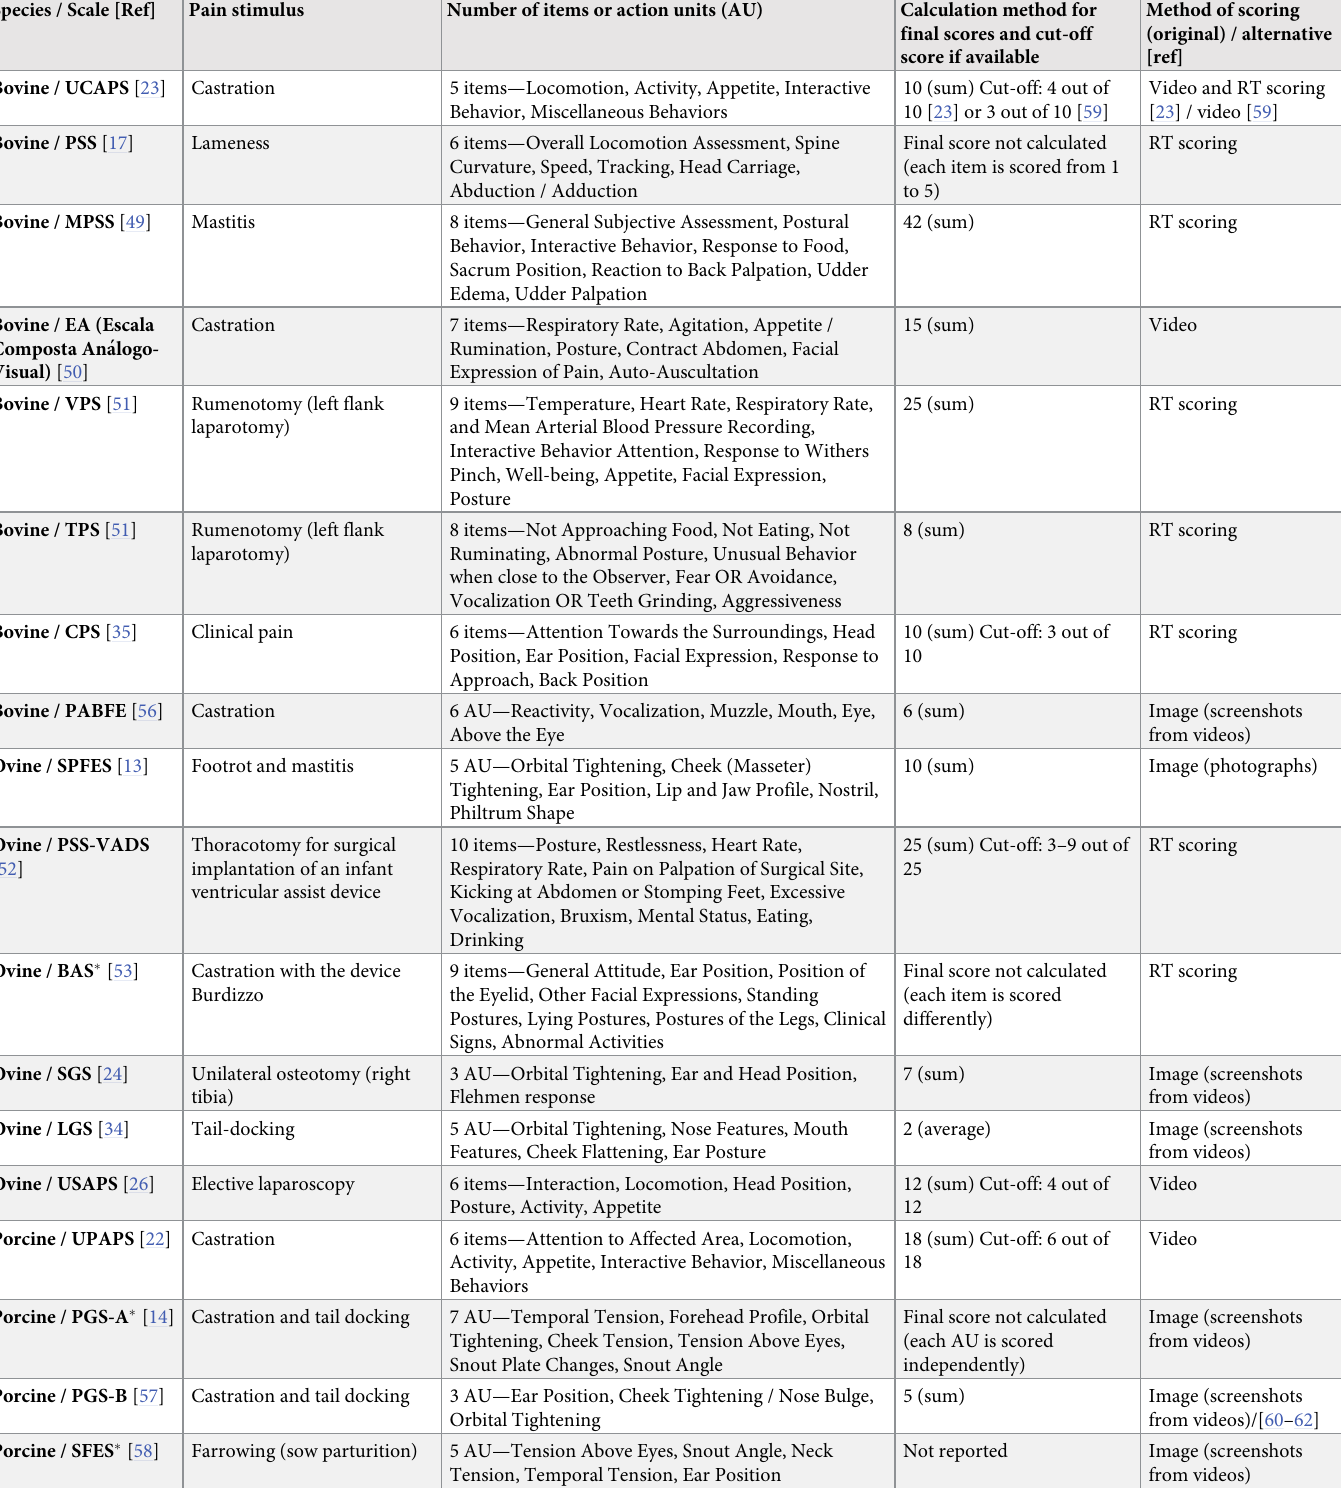
Table 4. Summary of characteristics of pain scoring instruments in farm animals included in this systematic